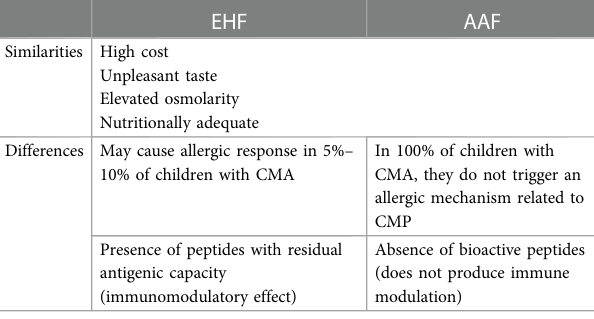
TABLE 2 Advantages and limitations of amino acid and extensively hydrolyzed formulas. EHF